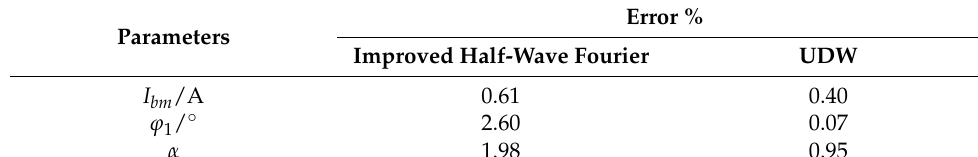
Table 2. The comparison of the two waveform prediction methods. Parameters